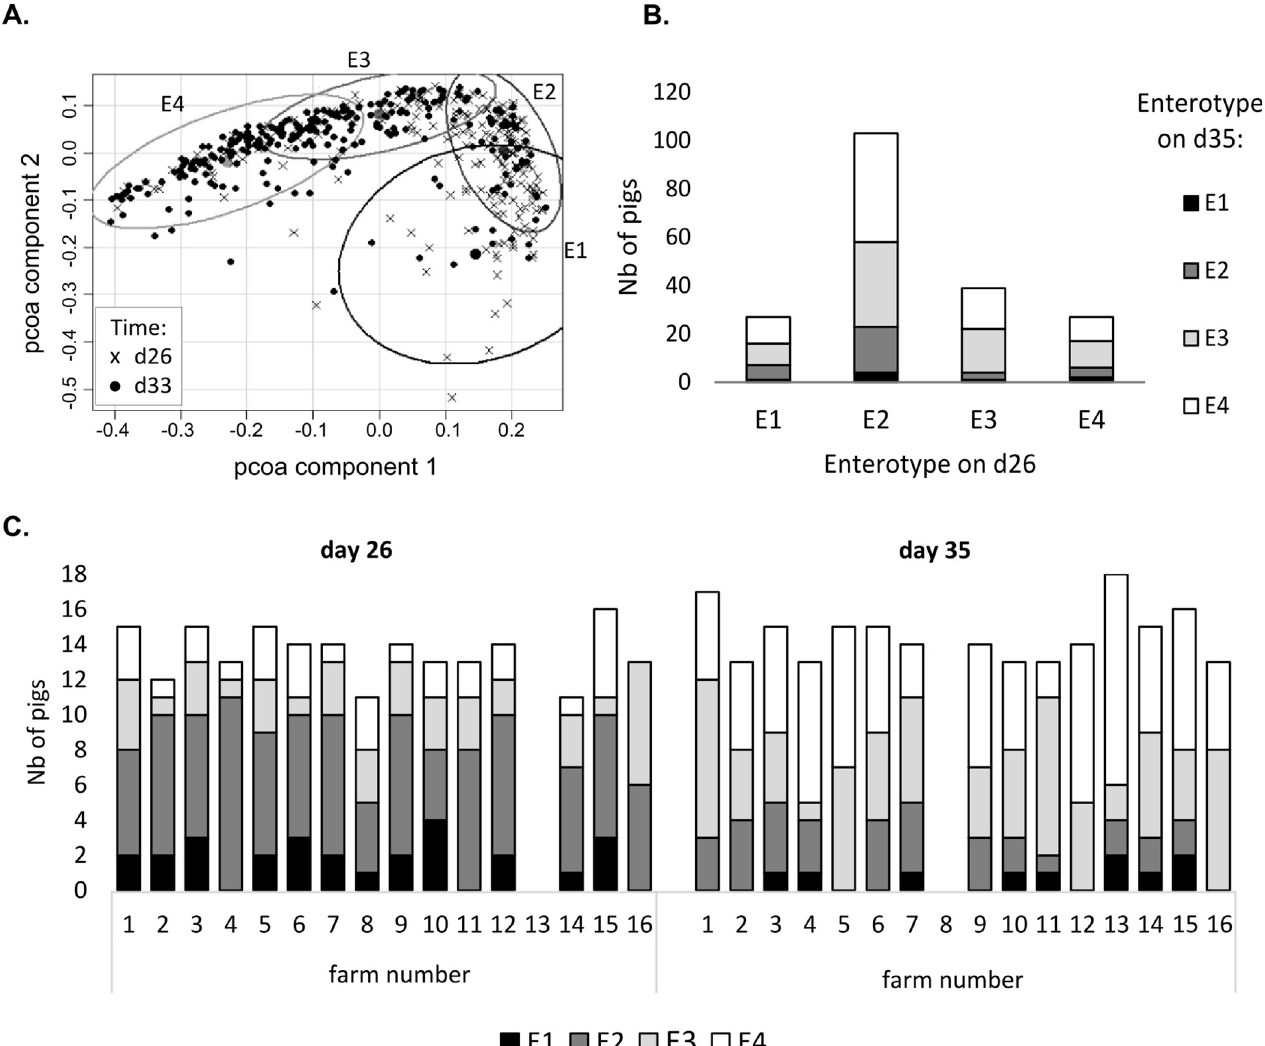
Fig 3. Enterotypes identified in fecal samples from piglets. Four enterotypes named E1 to E4 (A) were identified among the samples collected from suckling 26-day-old (n = 222) and weaned 35-day-old piglets (n = 254) in 16 commercial farms. The 192 pigs with data available at both time points were used to show the proportion of pigs switching from one enterotype to another between d26 and d35 (B). The variability between farms is illustrated by the distribution of enterotypes at d26 and d35 in each farm